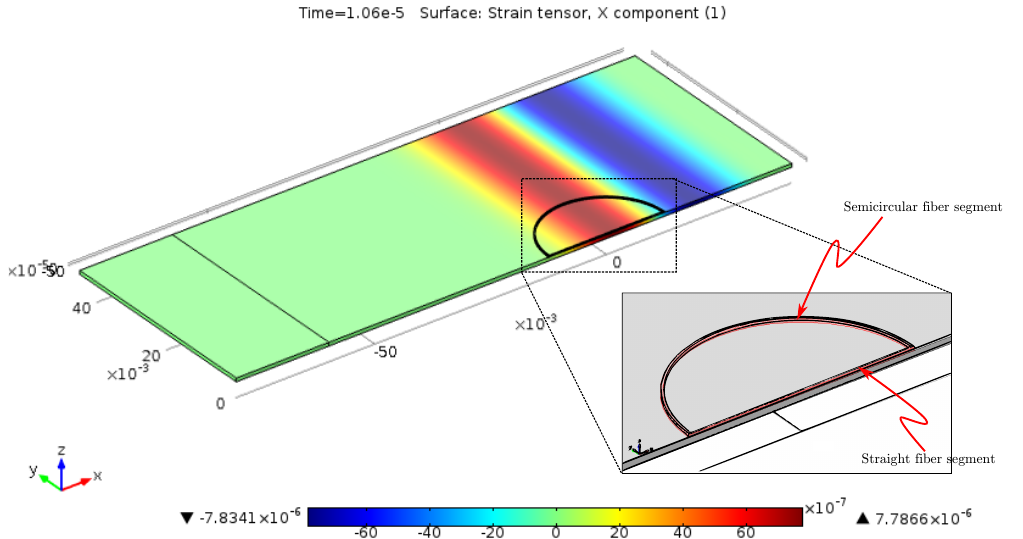
Figure 4. FEM model exhibiting a snapshot of a 100-kHz plane S 0 strain pulse, with the aluminum plate as the monitoring structure. The attached sensor fiber segment is at the same time a straight piece and a